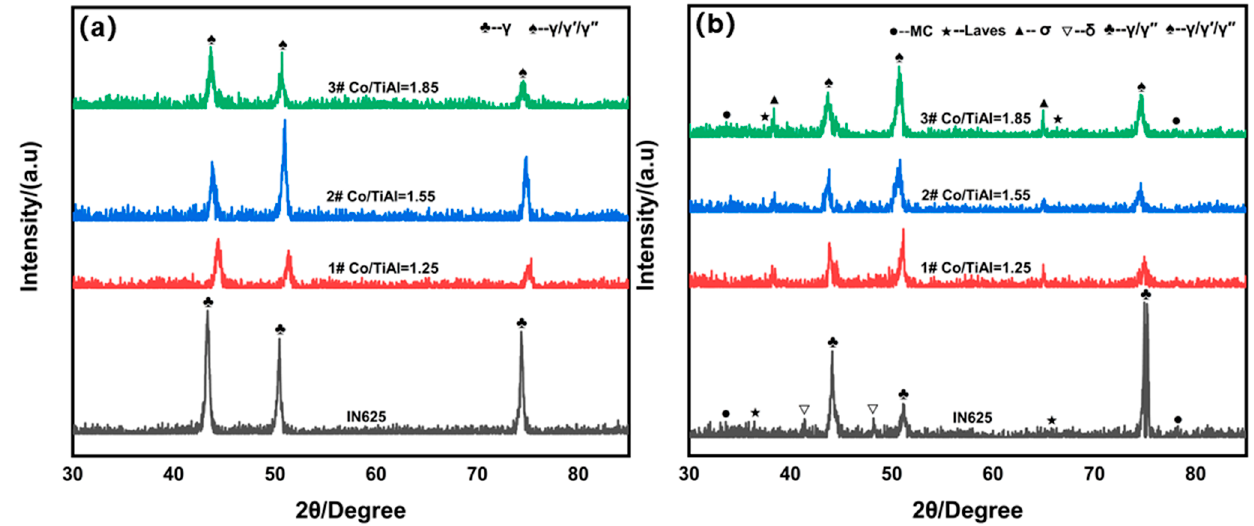
Figure 2 . XRD patterns of IN625 and three different Co/TiAl IN625 coatings 1#, 2# and 3# (( a ) Without heat treatment, ( b ) after heat treatment).